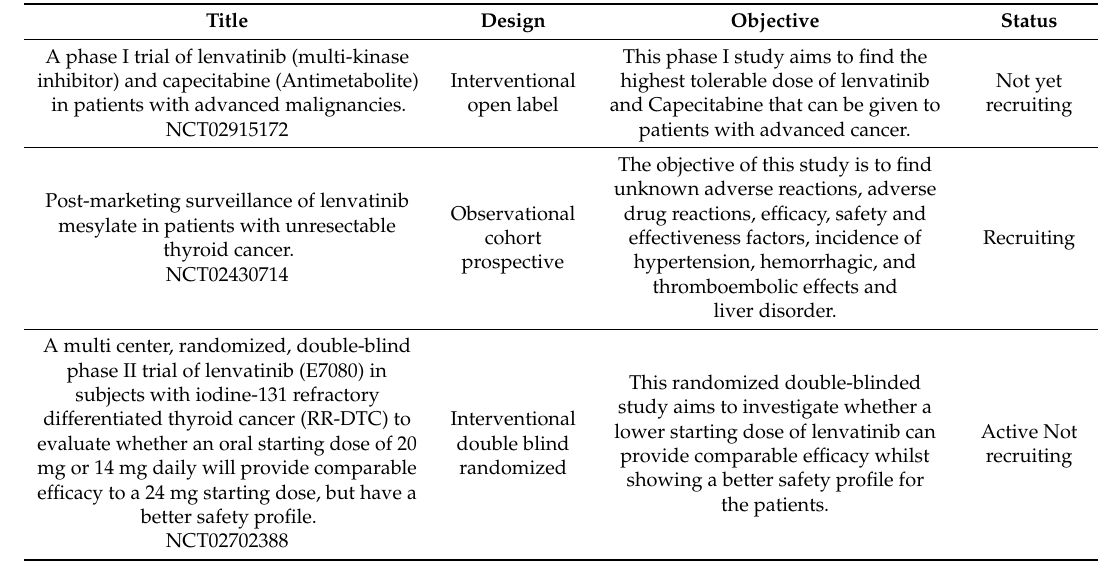
Table 2. Overview of recent clinical trials studying lenvatinib, sunitinib, and sorafenib, website used on 7 March 2017